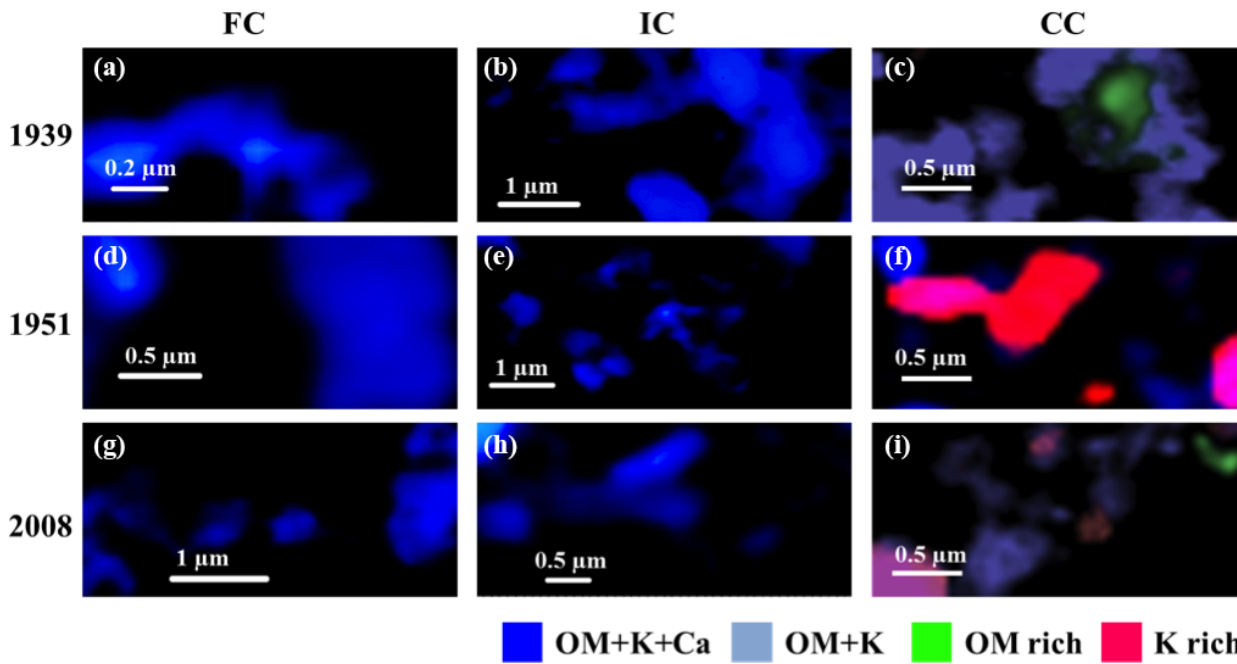
Figure 6. STXM-NEXAFS compositional maps of organomineral particles contained in the fine clay (a, d, g) , intermediate clay (b, e, h) , and coarse clay (c, f, i) subfractions on three different dates: 1939 ( a–c ), 1951 ( d–f ), and the final sampling in 2008 ( g–i ). The scale bar is represented by a white line in each panel, it varies from 0.2 to 1µm and depends on the sample. Dark blue represents OM + K + Ca, light blue represents OM + K, green represents OM-rich, and red/pink represents K-rich. The corresponding spectra are shown in Fig. 5.